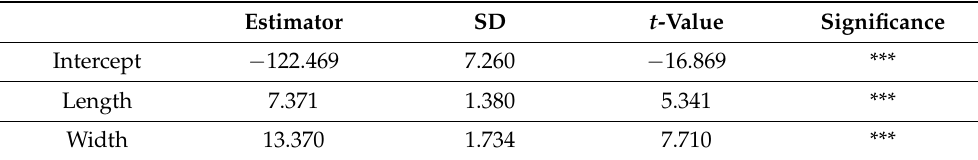
Table 3. Results obtained from the linear model implemented in